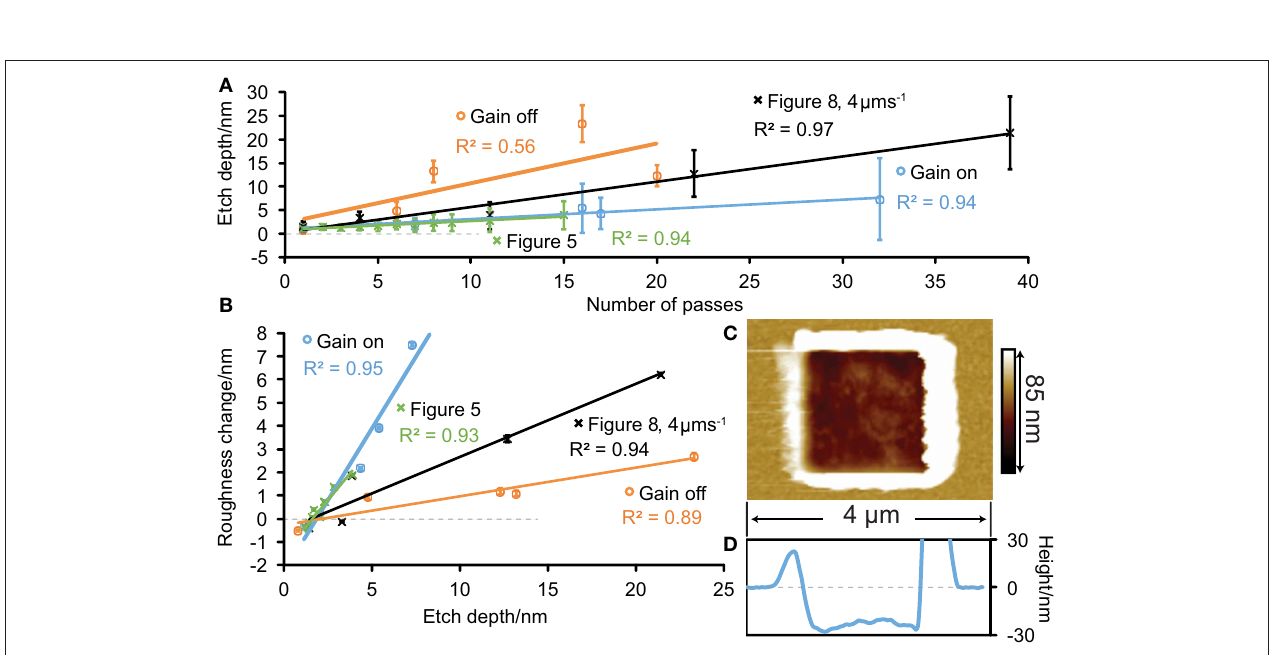
FIGURE 9 | The contrast in gold etching between standard gain settings and turning the gain channels off, compared to previous data presented herein. (A) Etch depth with number of passes, demonstrating a steeper increase in etch depth with number of passes when the gain is off, though with a relatively poor linear fitting. (B) Roughness change with etch depth, demonstrating that switching the gain off significantly reduces the roughening effect. (C,D) Topography and step profile, respectively, of the deepest trench produced with the gain off, for 15 passes. The base is relatively smooth.